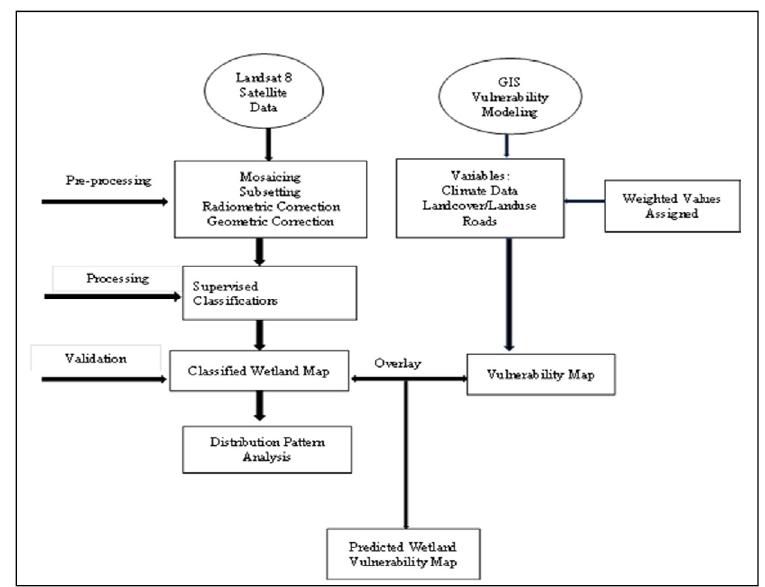
Fig. 2: A schematic representation of the methodological approach used to classify, map and model inland wetlands distribution pattern and vulnerability